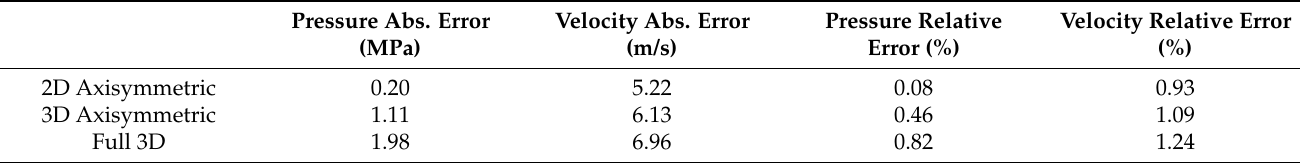
Table 2. Absolute errors of simulations vs. experimental data. Pressure Abs.